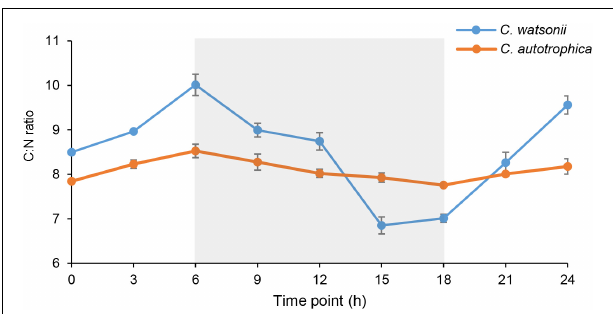
FIGURE 1 | Diel variation of carbon to nitrogen (C:N) molar ratios in Crocosphaera watsonii and Chlorella autotrophica cells. The night-time (6th–8th h) was indicated with shaded area. The C:N ratio of C. watsonii was significantly higher than that of C. autotrophica at the end of daytime; and it was significantly lower than that of C. autotrophica at the end of nighttime (Student’s t -test, p < 0 . 01).